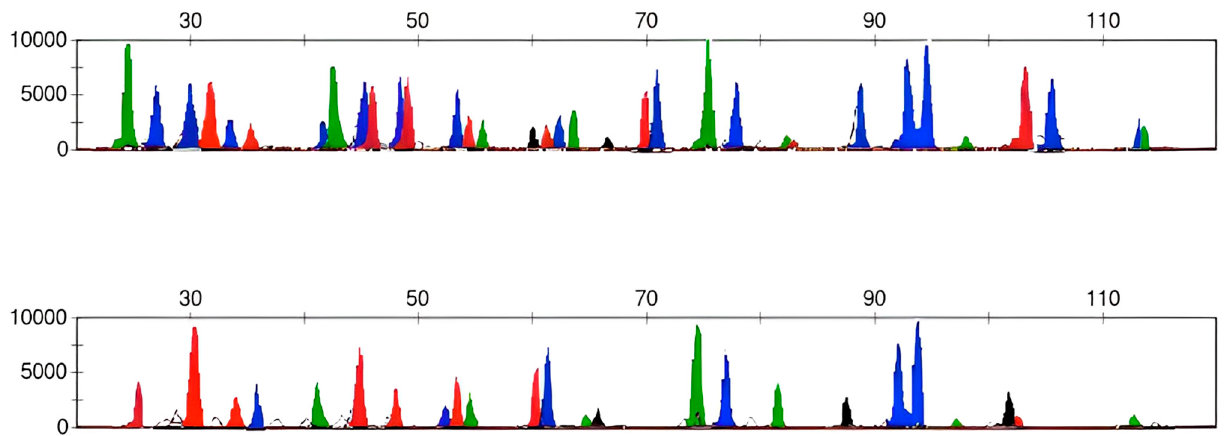
Figure 2. HIrisPlex-S SNP electropherogram obtained from sample I1. The electropherogram shows the amplified SNPs in the same order as those reported in Figure 3. Peaks show the different DNA bases, pointed using the following colour code: green (adenine), black (cytosine), blue (guanine), and red (timine).